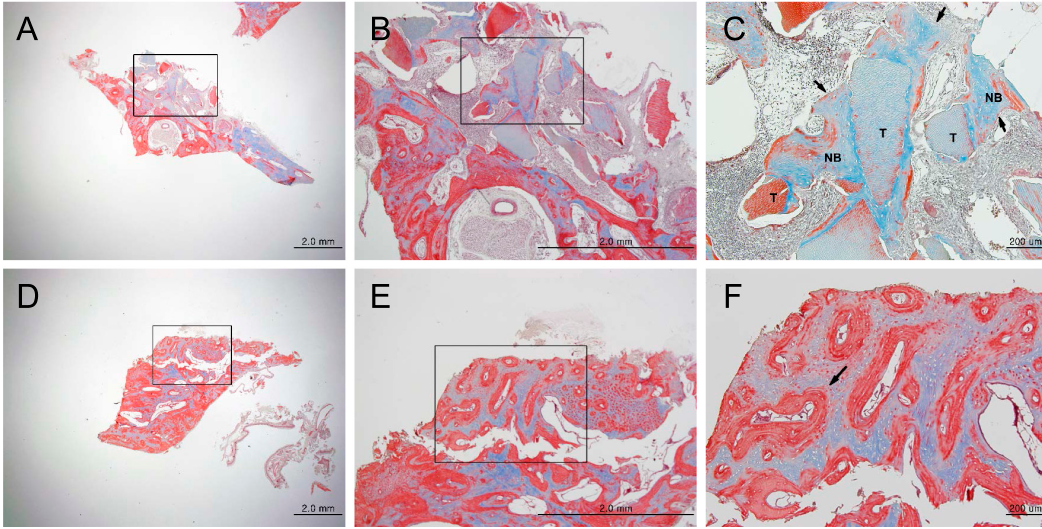
Figure 5. Masson-trichrome staining in each group showing findings for new bone formation after eight weeks (magnification: ( A , D ) 12.5×; ( B , E ) 40×; ( C , F ) 100×). ( A – C ) Experimental group (DDM fixed with rhBMP-2); ( D – F ) Control group (autogenous bone graft). Figures ( B ) and ( E ) are higher magnification views of figures ( A ) and ( D ), respectively. Figures ( C ) and ( F ) are higher magnification views of figures ( B ) and ( E ), respectively. ( C ) General woven bone (blue color) formed around the TCP and mineralized bone (red color) was seen (arrow). ( F ) The amount of mineralized bone (red color) was greater in the autogenous bone graft group (arrow).